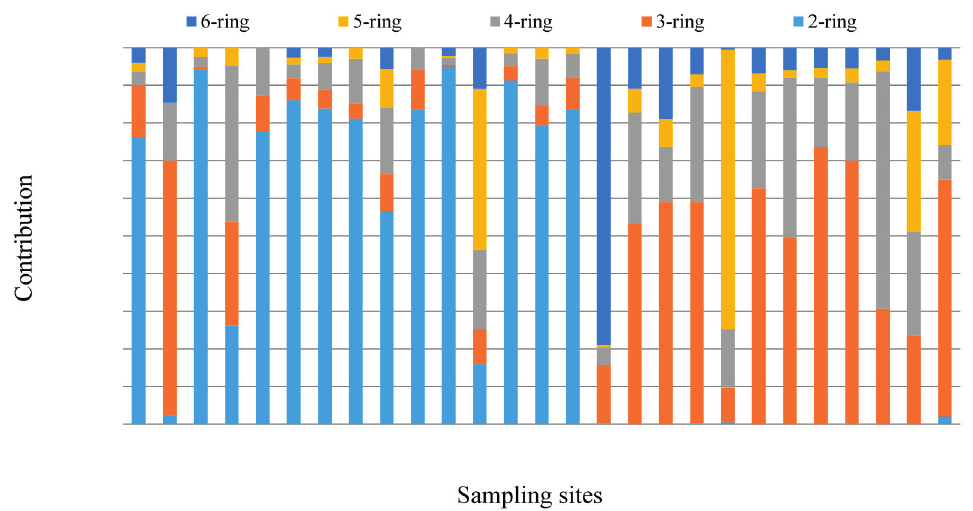
Figure 3. Composition of PAHs in different sampling site soils of the oilfield (2-ring: Nap; 3-ring: Ace, Flu, Phe, and Ant; 4-ring: Fla, Pyr, Baa, and Chr; 5-ring: BkF, BaP;